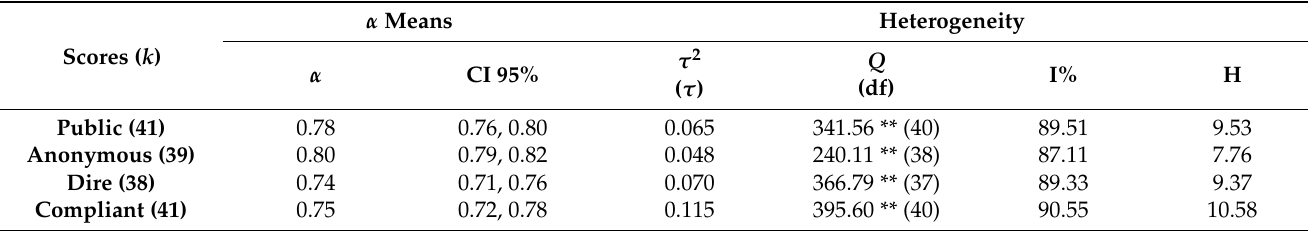
Table 2. Estimates for PTM reliability